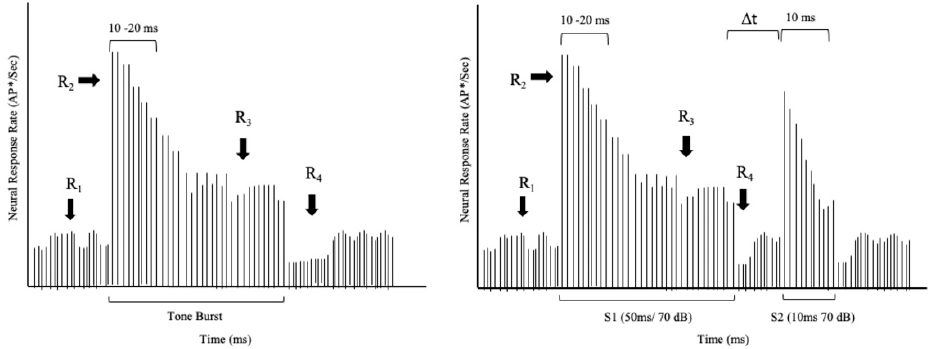
Figure 1. Single auditory fiber response to a single tone ( left panel). Individual fiber response to successive tones ( right panel). Single fiber response to successive tones (* AP denotes action potentials). (Adapted from Pickles, 2013, pp. 76–90.).